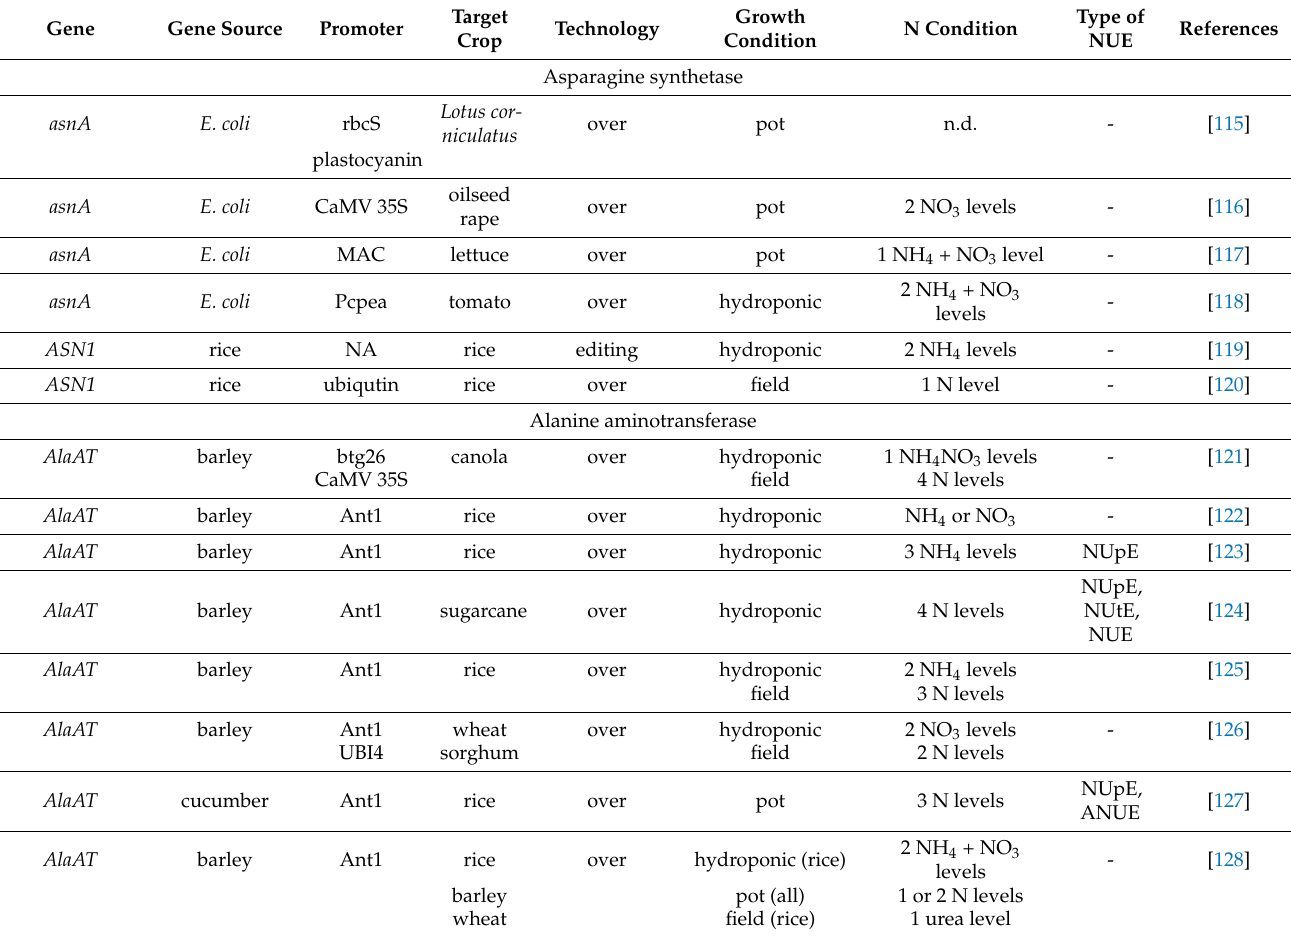
Table 3. Manipulation of nitrogen remobilization and translocation genes in